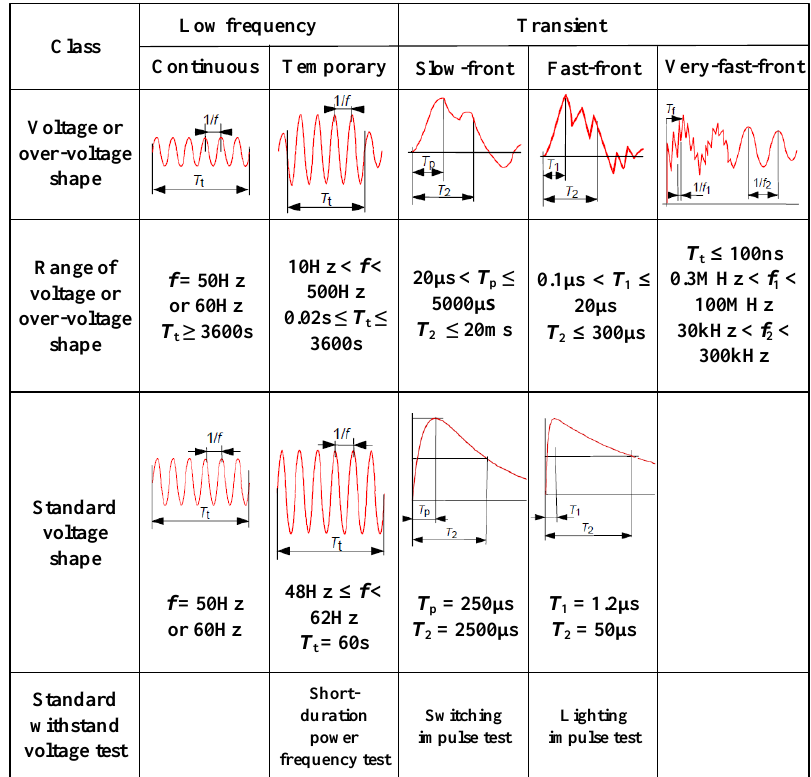
Figure 5. Classes and shapes of overvoltages, standard voltage shapes, and standard withstand voltage tests [60]. “Copyright © 2019 IEC Geneva, Switzerland